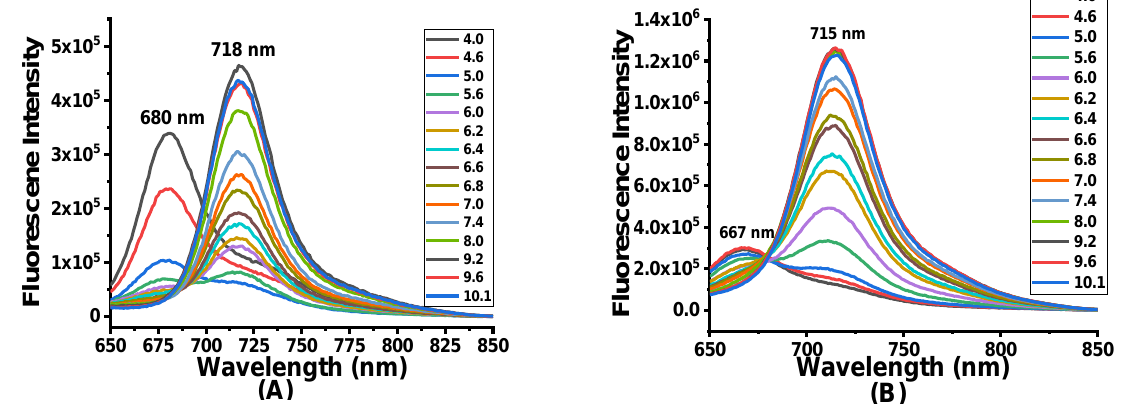
Figure 3. Fluorescence spectra of 10 µM probes AH + ( A ) and BH + ( B ) in buffers with pH changes from 4.0 to 10.1 under excitation at 630 nm.